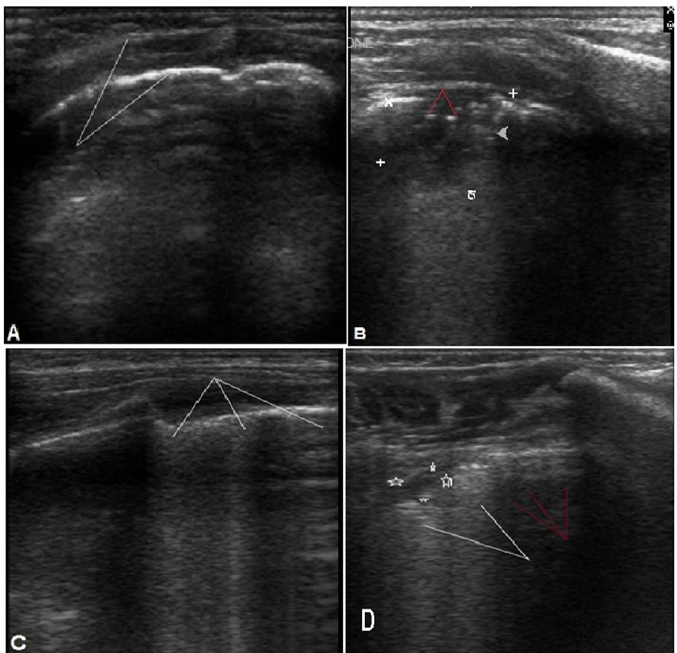
Figure 2. Different LUS findings in bacterial and viral pneumonia. ( A , B ) for bacterial pneumonia: ( A )